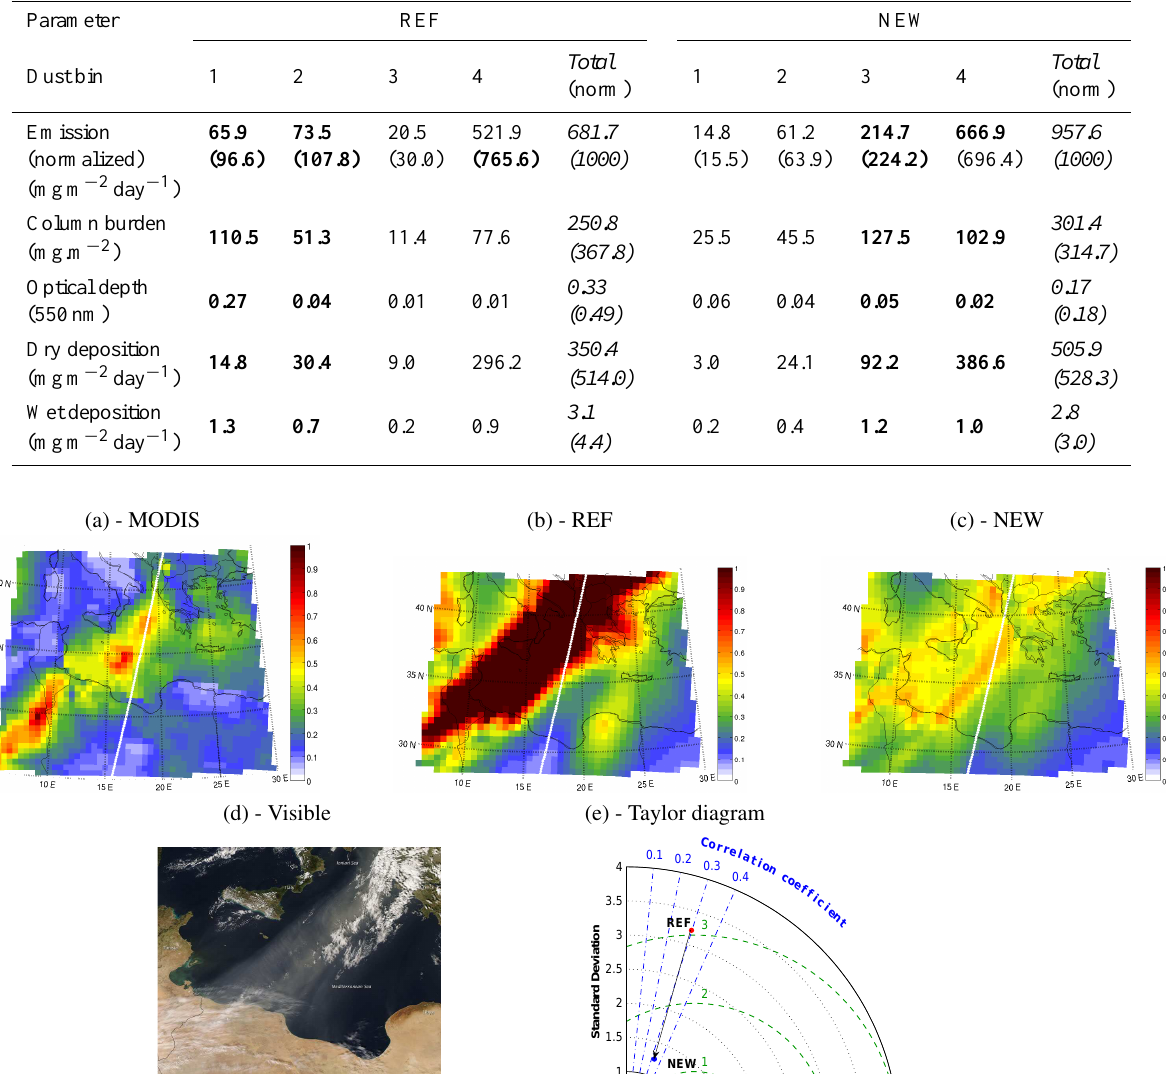
Table 1. Average dust emission, integrated concentration, optical depth (550nm) and deposition during the outbreak (31 October–2 Novem- ber 2008) over the affected zone (25–43 ◦ N, 5–30 ◦ E) for each dust bin. 1: 0.01–1.0µm, 2: 1.0–2.5µm, 3: 2.5–5.0µm, 4: 5.0–20.0µm. The largest value for each bin is indicated in boldface. The normalized value (for a total emission of 1000mgm − 2 day − 1 ) of each term is indicated between brackets, and in a specific line for the emission of each bin.